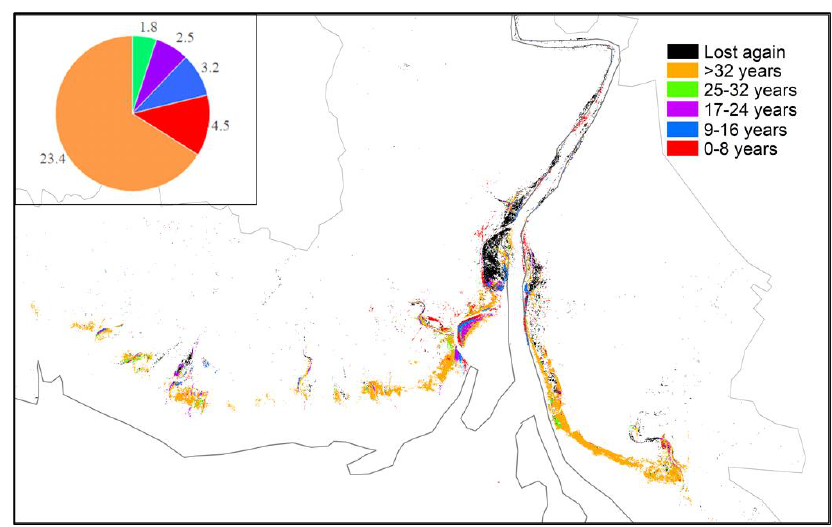
Figure 9. The spatial distribution and quantity of seepweed over time. The black color represents area where seepweed subsequently disappeared after expansion. The pie chart inset shows the area of seepweed in km 2 that emerged over time and/or was resident at the beginning of our study years.